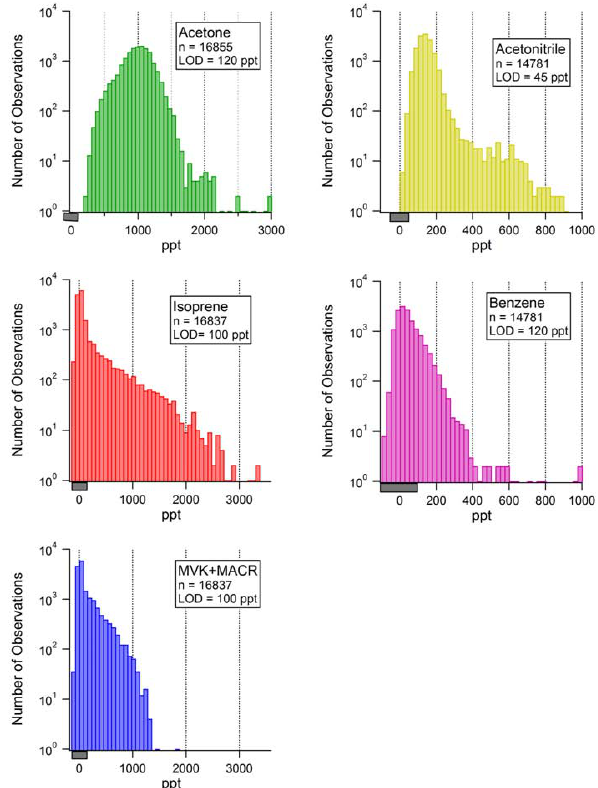
Fig. 1. Histograms of the distribution of observations of acetone, acetonitrile, isoprene, benzene, and the sum of methyl vinyl ketone and methacrolein. The total number of points in each histogram is given in the legend, along with a conservative estimate of the 3 σ limit of detection for 1s measurements, which is also indicated visually using a grey bar along the